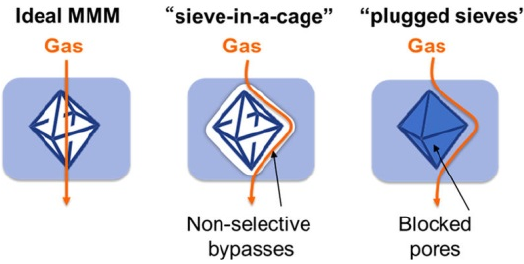
Figure 14. Ideal and nonideal MOF MMM architectures. Reprinted with permission from [118], Copyright (2019) American Chemical Society.